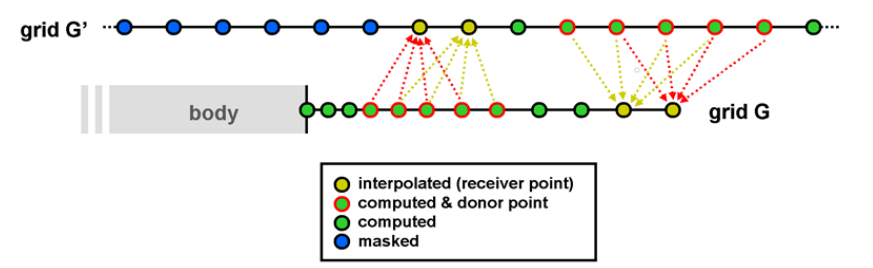
Figure 6. Sketch of a valid mesh overlap leading to a successful donor search for two mesh compo- nents [15].